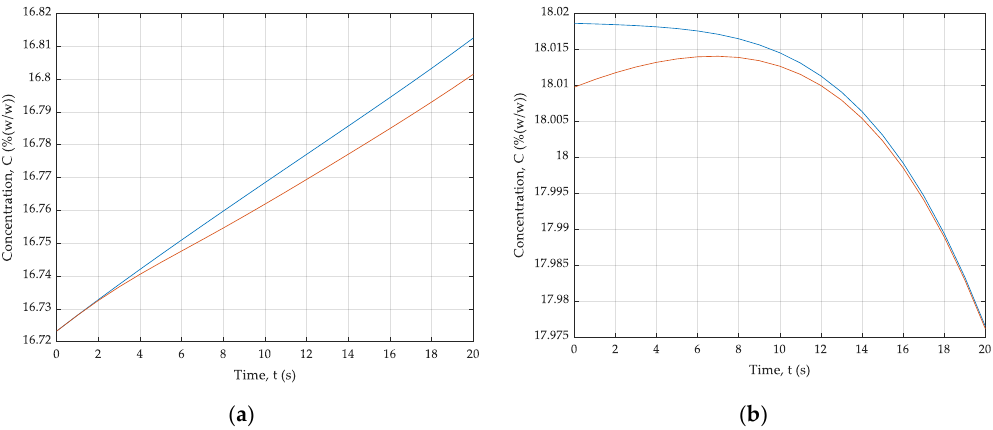
Figure 8. History of the concentration over time: ( a ) from 22 to −5 °C and ( b ) from −5 to 22 °C.